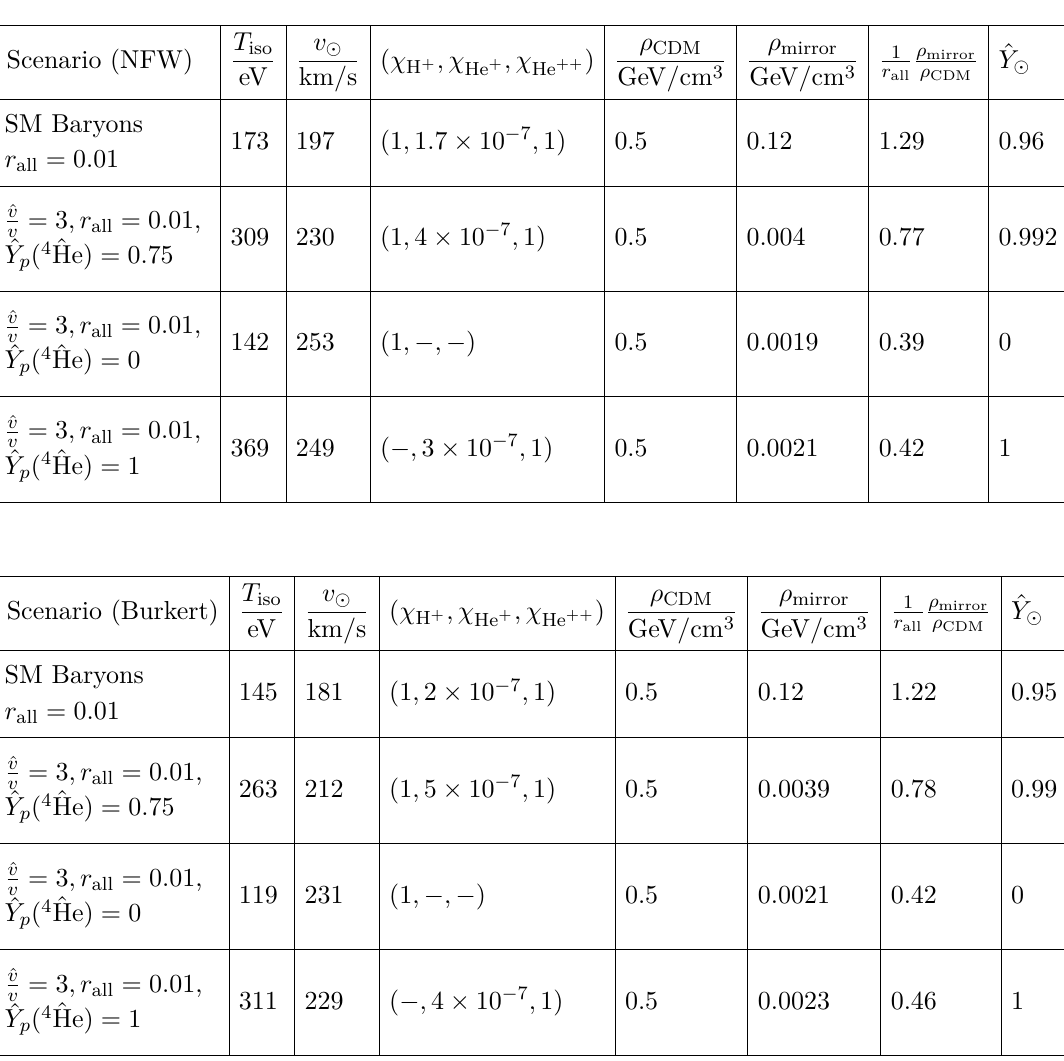
Table 2 . Isothermal halo parameters at r = R (cid:12) = 8 kpc for some benchmark mirror baryon scenarios. v is the mean velocity of mirror baryon constituents following a thermal distribution of (cid:12) temperature T . Temperature and ionization is constant throughout the halo. For each ˆ Y ( 4 ˆ He) iso p ρ mirror separately, the local mirror helium fraction ˆ Y , local mean velocity v , and the local 1 are (cid:12) (cid:12) r all ρ CDM almost independent of ˆ v/v and r , see text for discussion. As the halo cools, ˆ Y will be reduced as all (cid:12) mirror helium sinks to the bottom of the gravity well. The SM comparison scenario corresponds to evaluating the mirror baryon profile for ˆ v/v = 1 , r = 0 . 2 , ˆ Y ( 4 ˆHe) = 0 . 25 . This is presented to all p compare mirror halo parameters to a SM-like halo evaluated under the same assumptions, but does not represent the actual SM baryon distribution